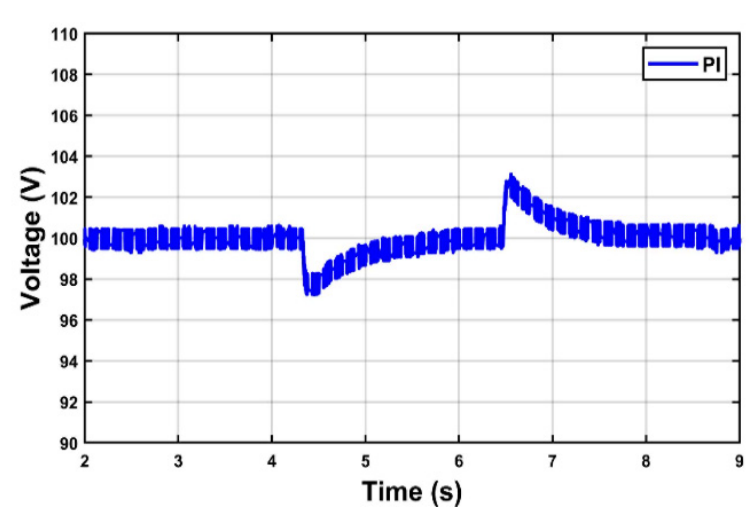
Figure 16. Output voltage response.